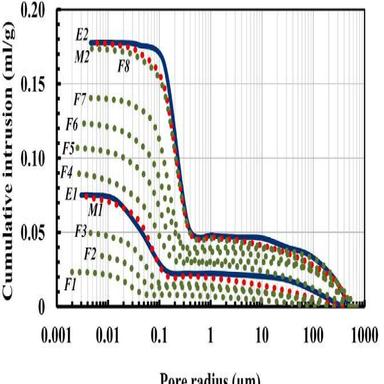
Pore cumulative curves. E1 and E2 (blue lines): experimental value from MIP test. M1 and M2 (red dotted lines): reconstruction by fractal nature analysis. F1–F8 (green dotted lines): prediction by fractal nature analysis. (For interpretation of the references to colour in this figure legend, the reader is referred to the Web version of this article.)